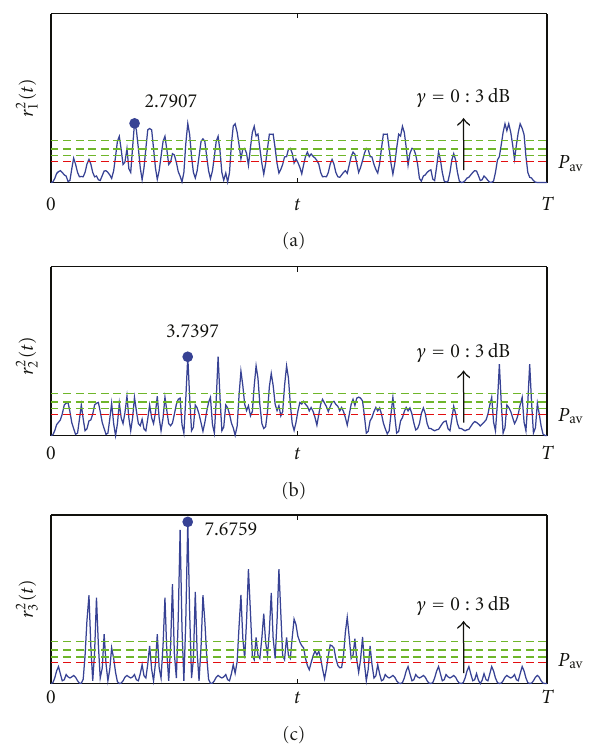
Figure 3: Instantaneous powers r 2 1 ( t ), r 2 2 ( t ), and r 2 3 ( t ) of represen- tations R1, R2, and R3, respectively, at di ff erent IBOs γ